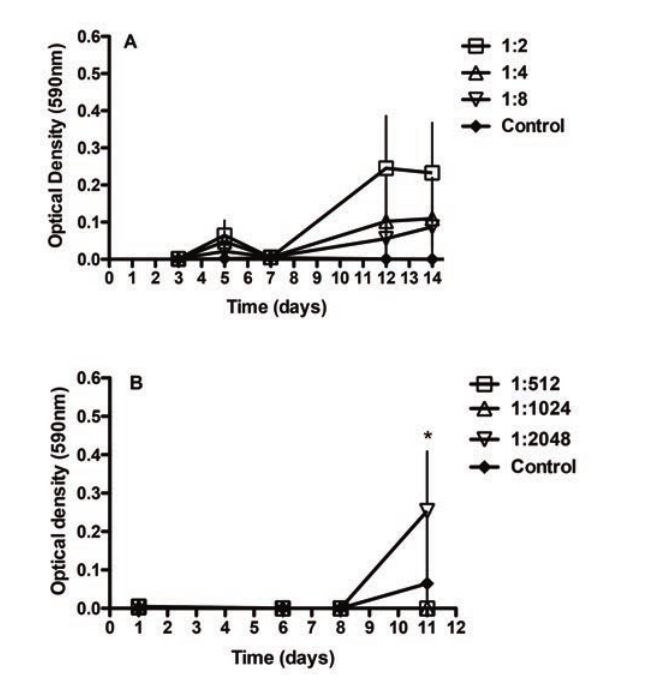
Figure 5. The concentration of Oxyrase® for Broth (OB) that enhances the recovery of dor- mant Mycobacterium avium subsp. paratuberculosis (MAP) is influenced by the number of viable organisms present. The optical density (590 nm) of MAP grown in Middlebrook 7H9C containing serial dilutions of OB was measured every 2-4 days until growth ceased or contamination was observed. Only the dilutions of OB that affected MAP growth are shown. A) Growth of organisms in plates prepared from a high viability dormant culture. B) Growth of organisms in plates prepared from a low viability dormant culture. The asterisk indicates a significant difference between the control cultures and those treated with 1:2048 OB